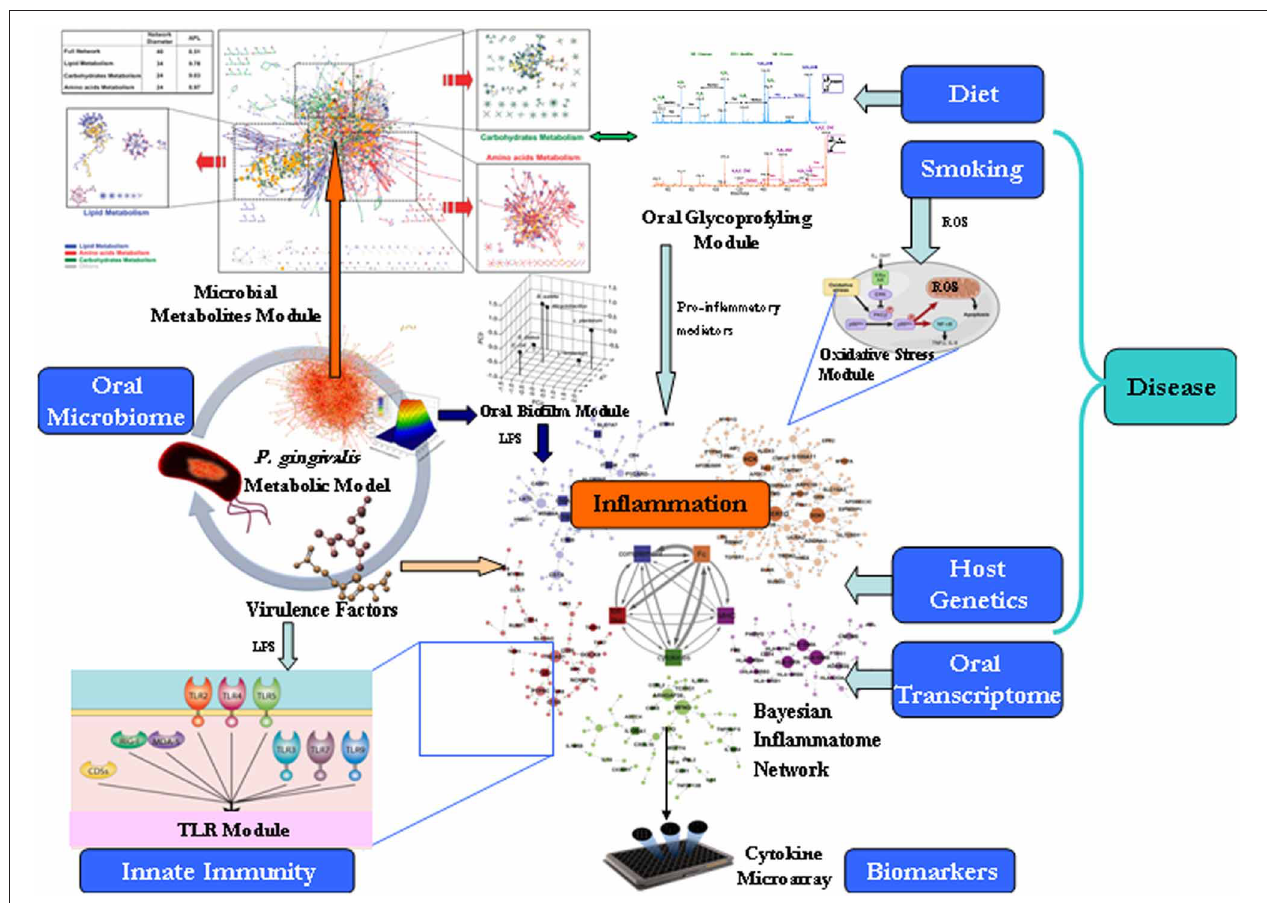
FIGURE 1 | Translational systems biology approach for modeling of the oral microbiome. The proposed framework of different modules need be treated differently, i.e., stored differently, queried differently, and shown